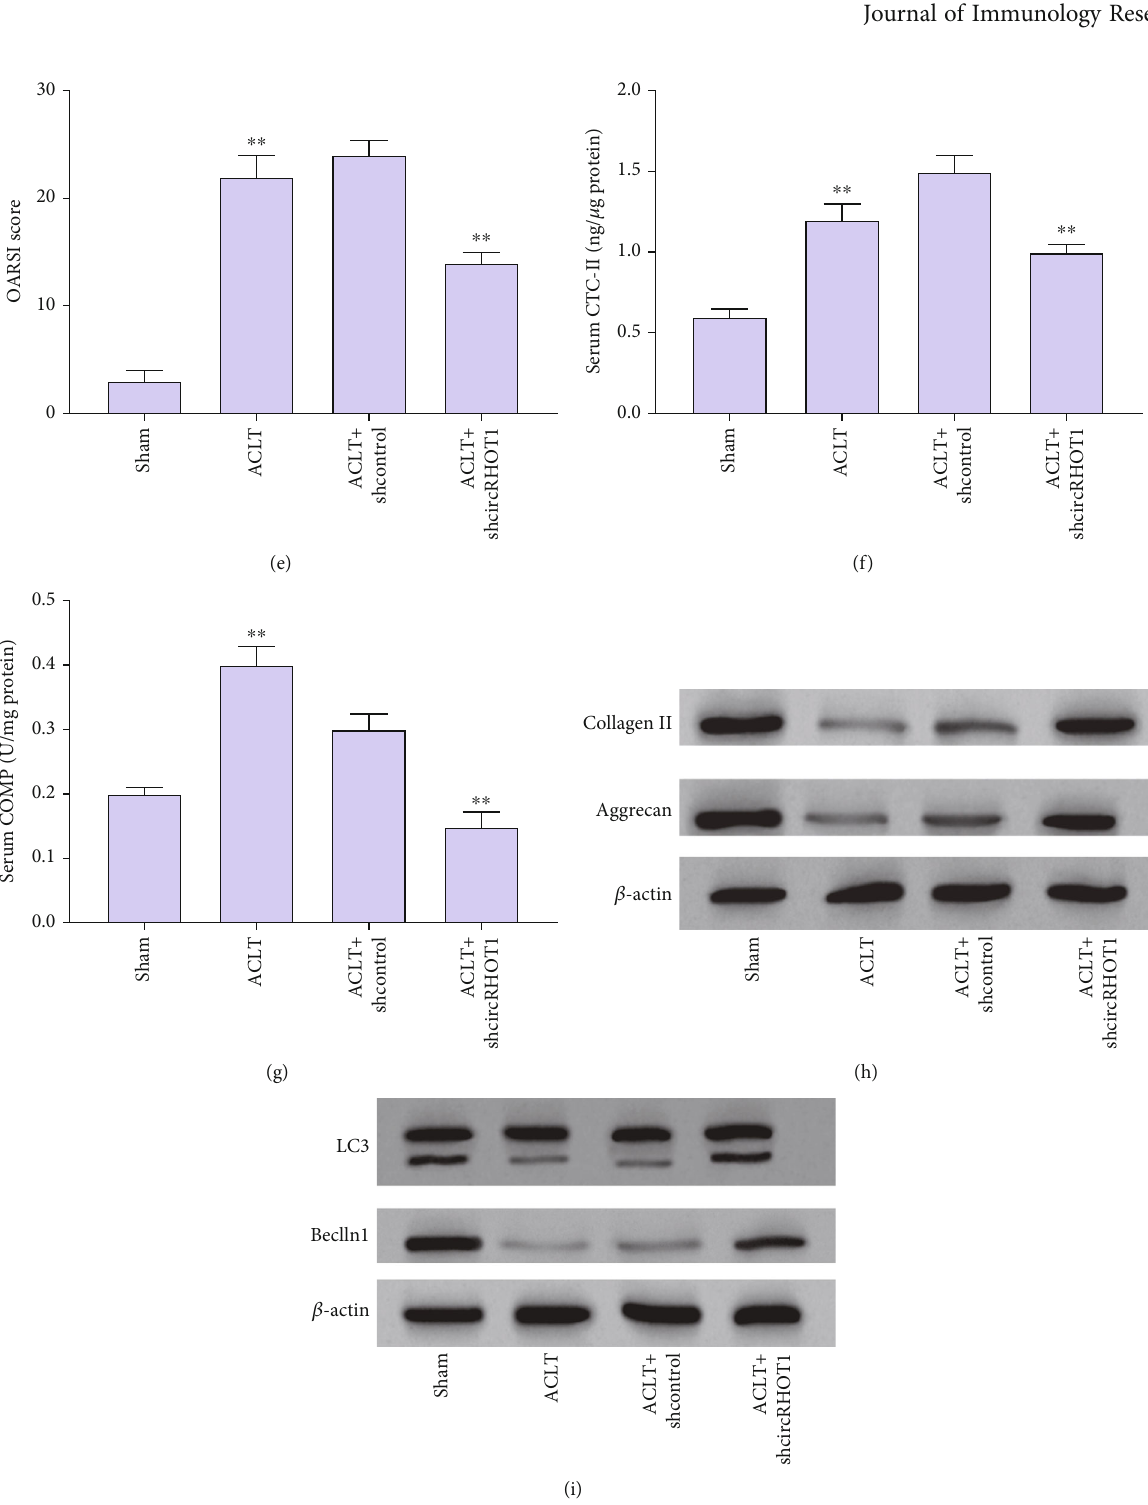
Figure 2: CircRHOT1 represses autophagy and in the OA rat model. (a) – (e) The OA rat model was constructed by receiving ACLT, and the OA rats were treated with circRHOT1 shRNA. (a) The expression of circRHOT1 was detected by qPCR. (b, c) The apoptosis was measured by TUNEL staining. Magni fi cation, × 40. (d, e) The articular cartilage degeneration was presented by Mankin score and OARSI score. (f, g) The serum levels of CTX-II and COMP were measured by ELISA assay. (h) The expression of collagen II and aggrecan was detected by Western blot analysis. (i) The protein expression of LC3 and beclin1 was detected by Western blot analysis. Mean ± SD , ∗∗ P < 0 : 01